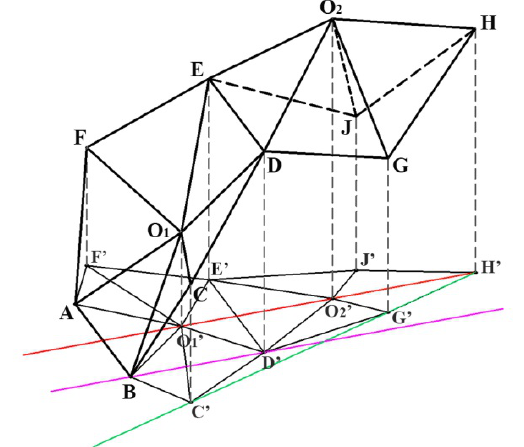
Figure 4. The unit cell of the Concave pyramid of the fourth sort and orthogonal projection onto the base